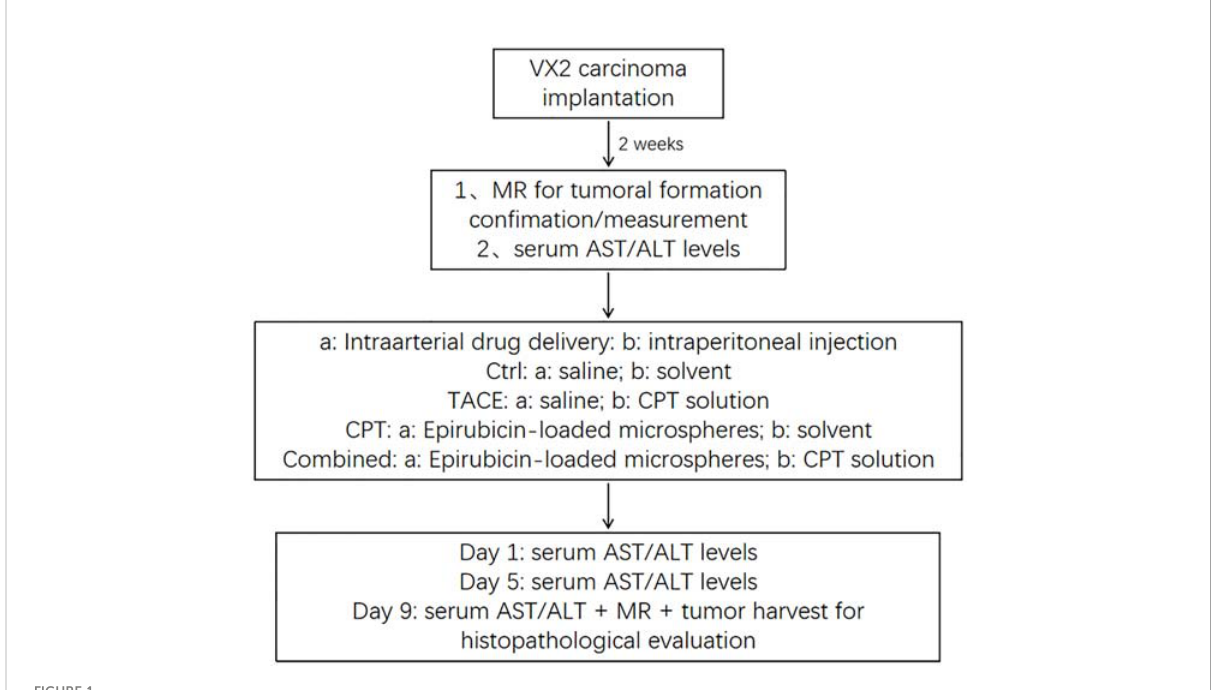
FIGURE 1 Overview of the experimental